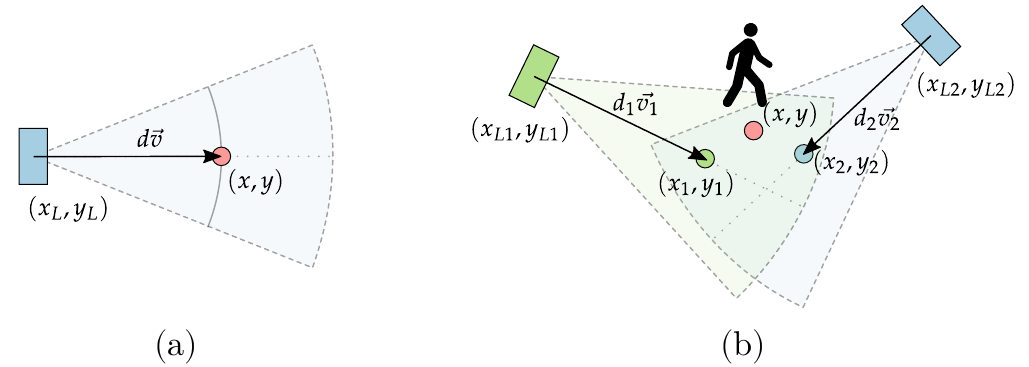
Figure 2. Localization using: ( a ) a single laser sensor, ( b ) multiple laser